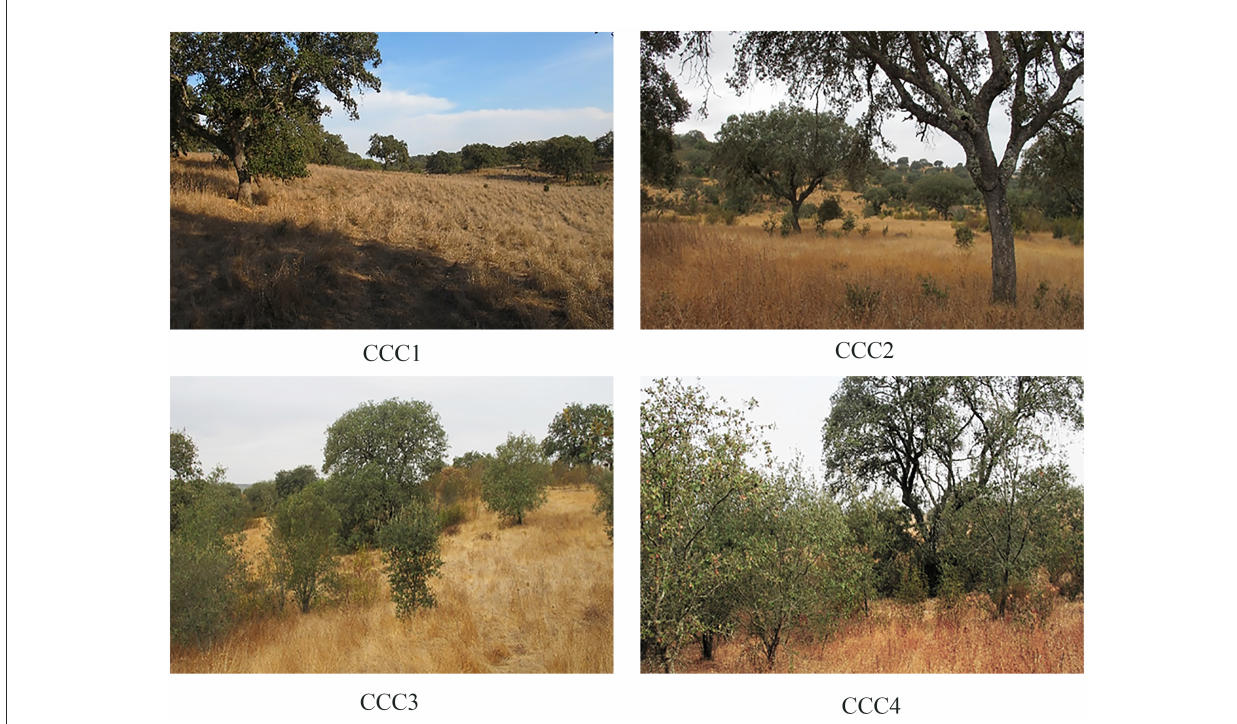
FIGURE1 Example of a plot of each crown cover class (CCC). Four crown cover classes (CCC) were defined: CCC1, < 10% CC; CCC2, 10–30% CC; CCC3, 31–50% CC; and CCC4, > 50% CC (Credit of the